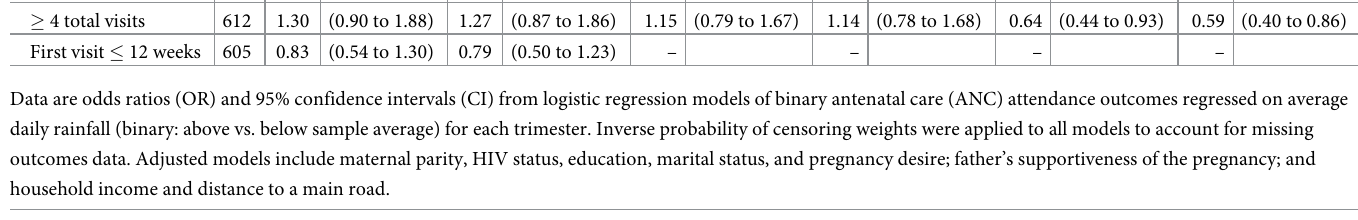
Table 4. Relationship between high rainfall during each trimester of pregnancy and antenatal care (ANC) attendance, VHEMBE study, South Africa, 2012–2013.